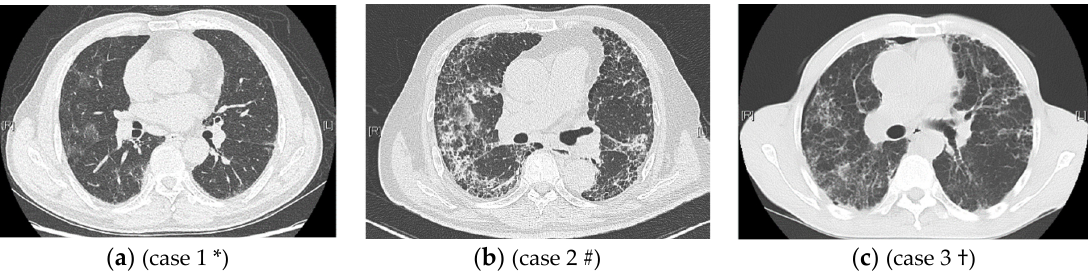
Figure 4. Different imaging manifestations of HRCT may affect the judgment of AI on glucocorticoid sensitivity. * Case 1 HRCT mainly shows ground glass opacity and was correctly identified as sensitive to glucocorticoids using the AI model. # Case 2 HRCT shows mainly reticulations and honeycombing and was correctly identi fi ed as insensitive to glucocorticoids using the AI model. † Case 3 is mainly characterized by ground glass opacities, reticulations, and honeycombing and was incorrectly identified as sensitive to glucocorticoids using the AI model.